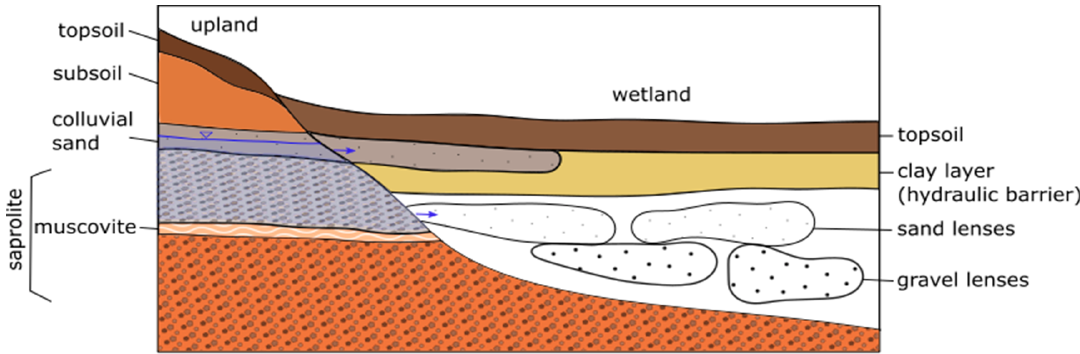
Figure 11. Schematic representation of the geology at the slope toe and the transition to the wetland. The blue area indicates the presence of interflow above the muscovite layer in the saprolite, and the blue arrows mark its connection and, hence, water passage into the shallow aquifer in the wetland soils, as well as to the aquifer in the valley sediments. Colors were chosen according to field observations where possible. Note that the extent of the different layers is not true to scale. The triangle shows the water table in the saprolite.